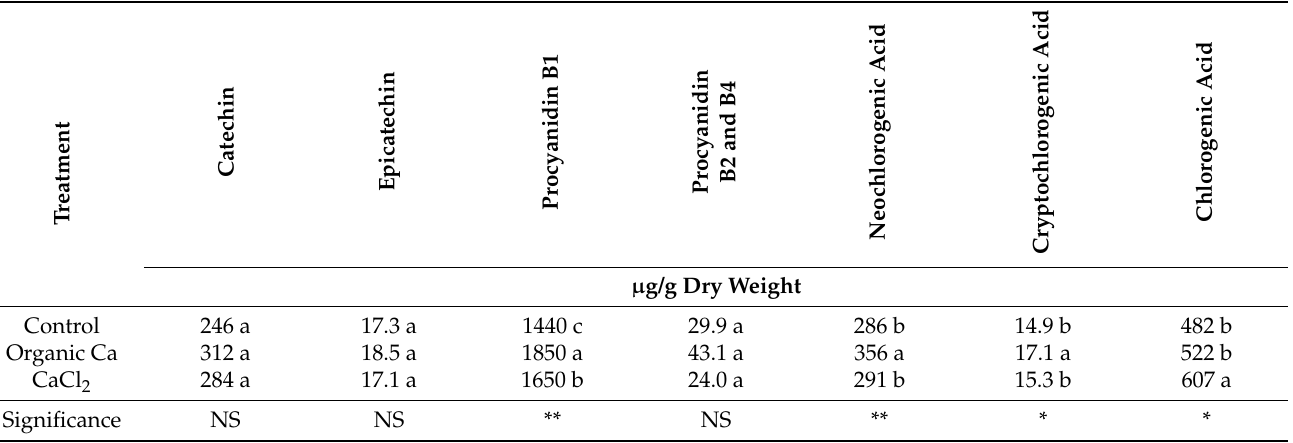
Table 6. The effect of the calcium formulation application on the major individual phenolic com- pounds at the Agios Vlasios orchard in